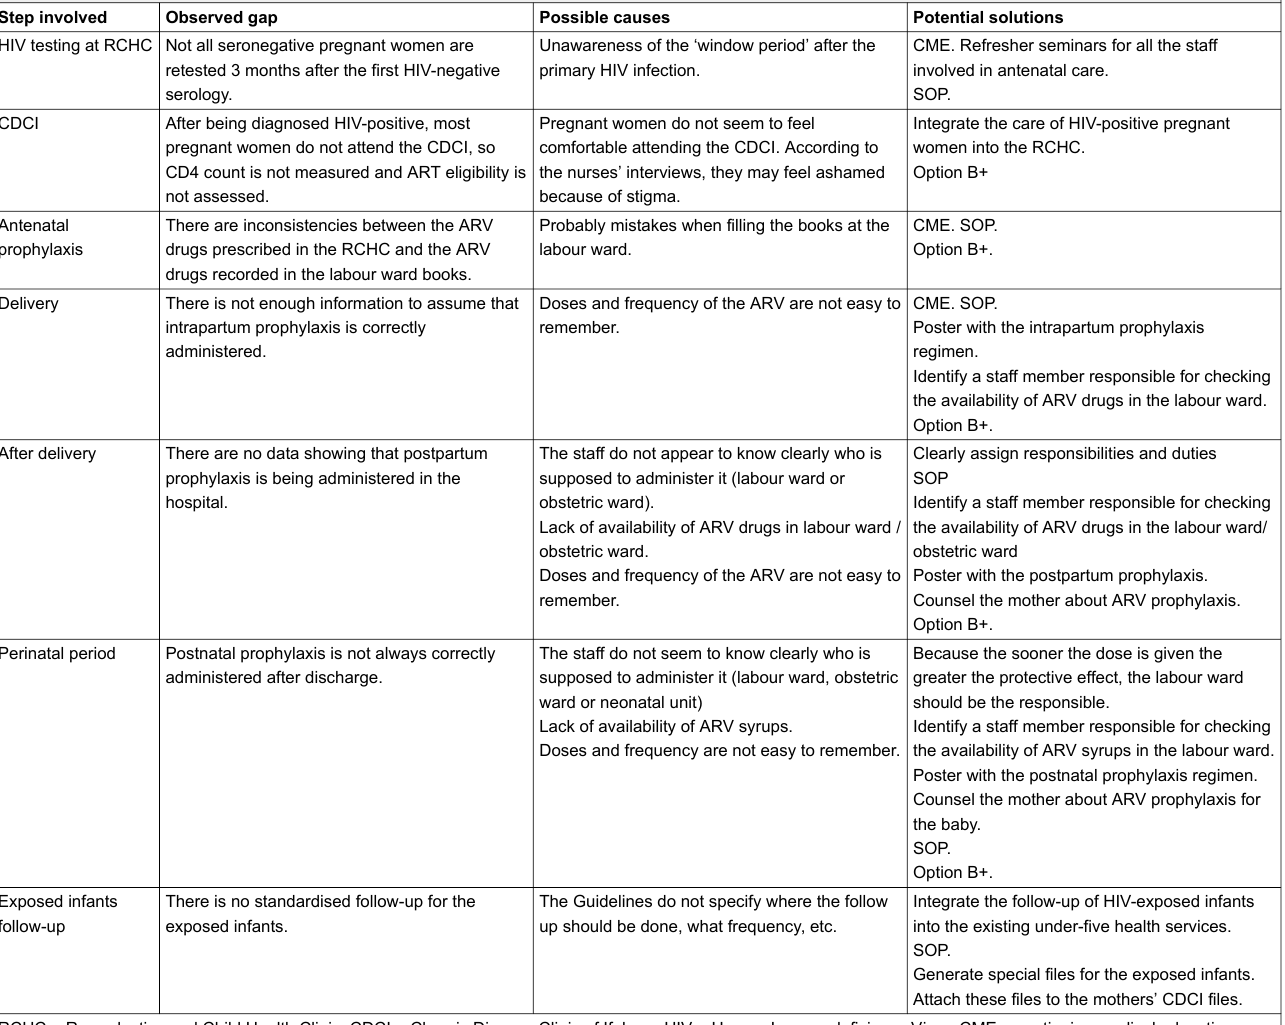
Table 3: Prevention of mother-to-child transmission (PMTCT) care pathway: observed gaps, possible causes, and potential solutions. Step involved Observed gap Potential